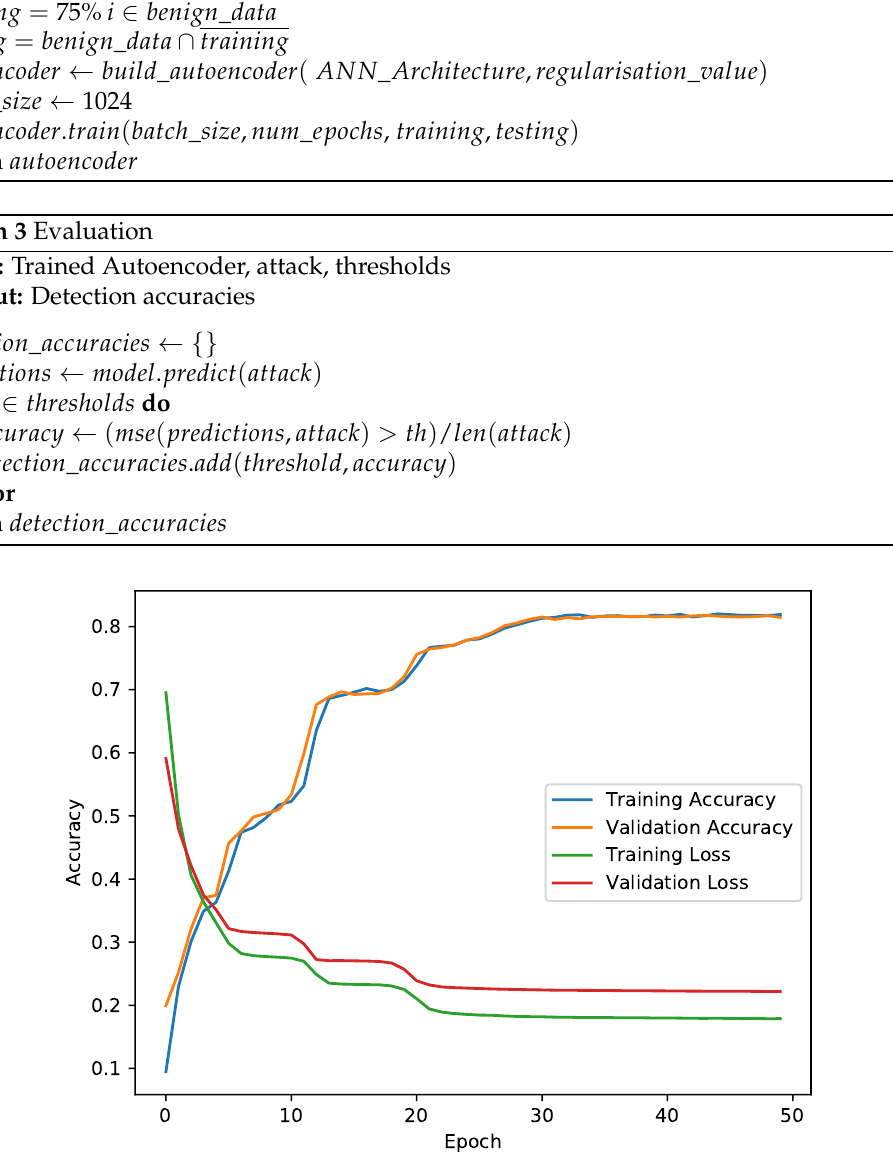
Figure 2. Autoencoder Convergence